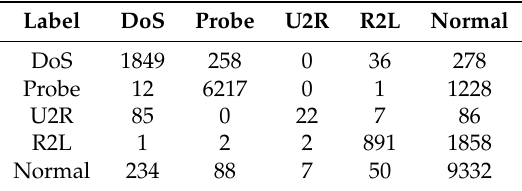
Table 13. Confusion matrix of